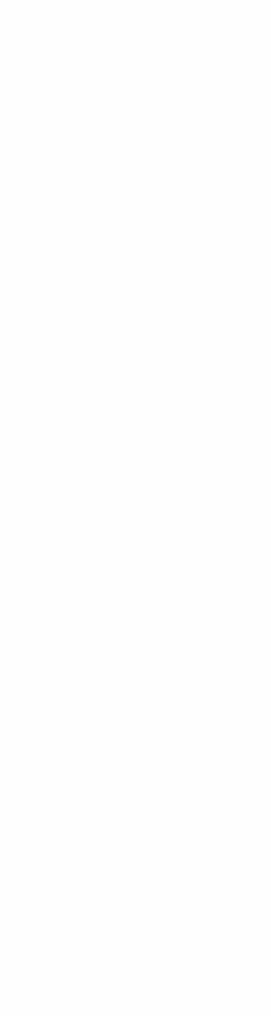
Fig. 4: Master curve for epoxy resin M 2 at the refer­ ence temperature of 60 oc